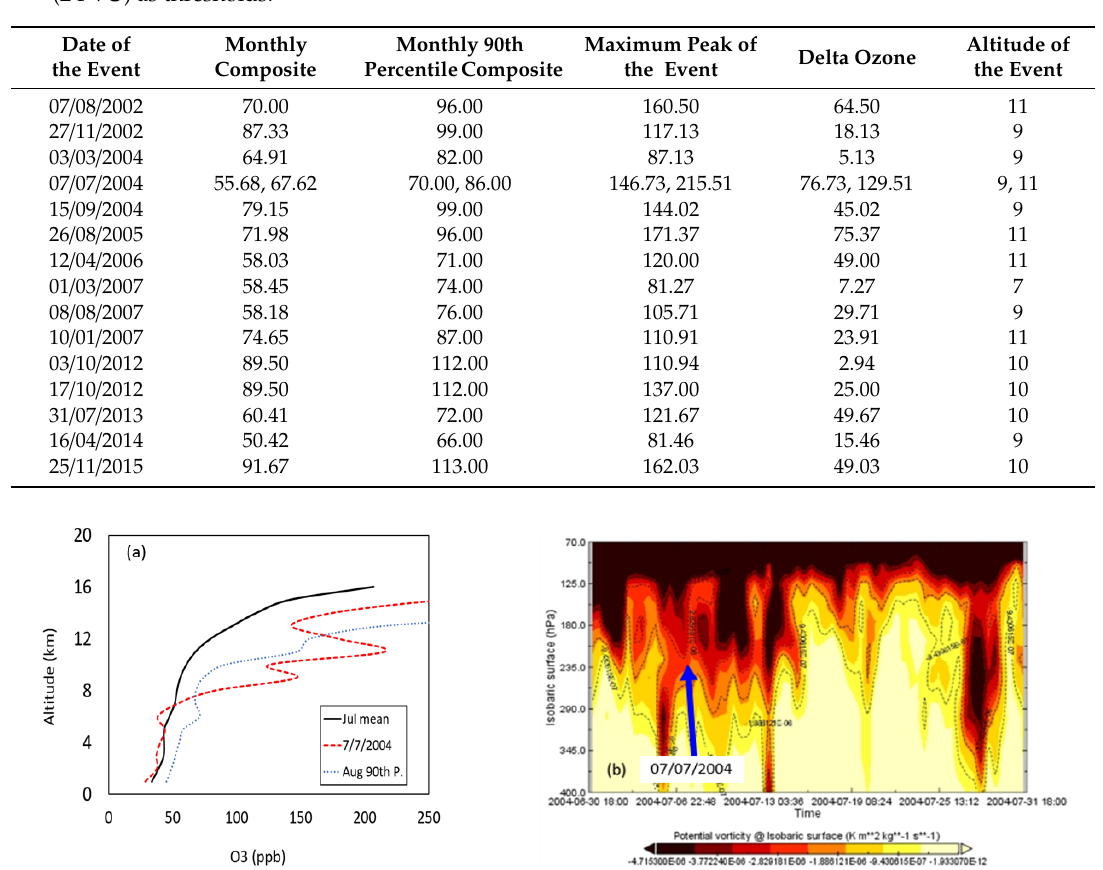
Figure 4. ( a ) Ozone troposphere profile over Irene on 07 July 2004. ( b ) Potential vorticity at Isobaric surface over Irene on July 2004 (from MERRA-2). Solid line in Figure 4a indicates monthly O 3 average composite, broken line indicates O 3 event and dotted line indicate 90 th percentile composite. Colours in Figure 4b indicates the level of potential vorticity, black indicates high potential vorticity of more than 3 Km −2 kg −1 s −1 while yellow indicates potential vorticity of less than 2 Km −2 kg −1 s −1 . Blue arrow in Figure 4b indicates the event that is associated with O 3 profile in Figure 4a.